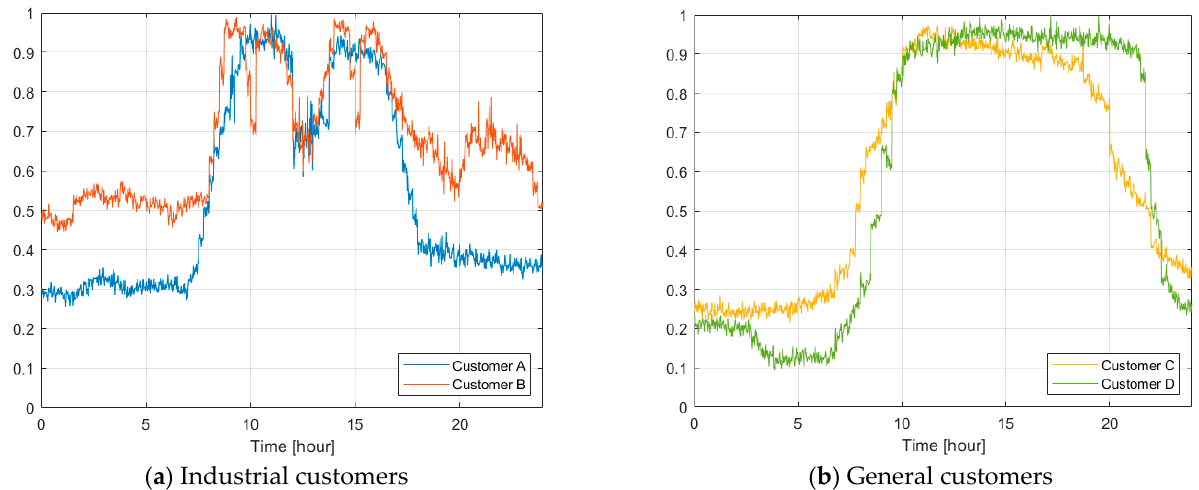
Figure 13. 1-min synthetic load profiles estimated by the proposed hybrid model: ( a ) Customers A and B and ( b ) Customers C and D.